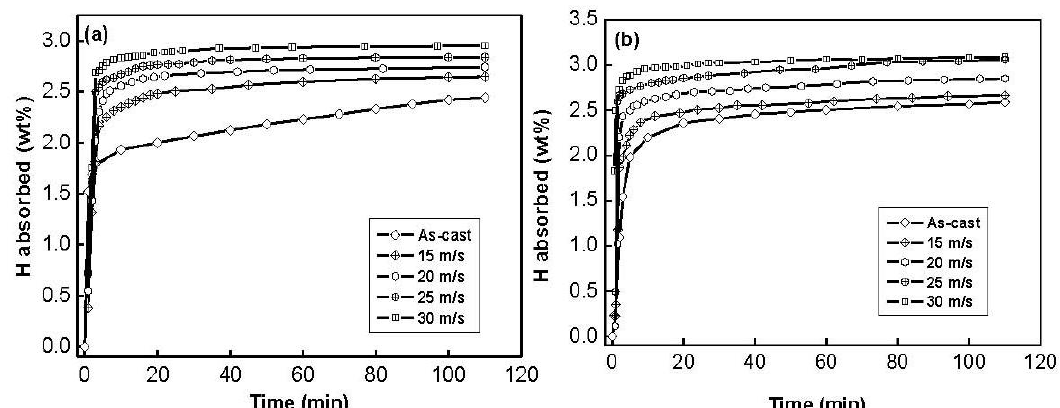
Figure 4. Hydrogen absorption kinetic curves of the as-cast and spun alloys: ( a ) Co alloy; (b) Co 0.1 0.4